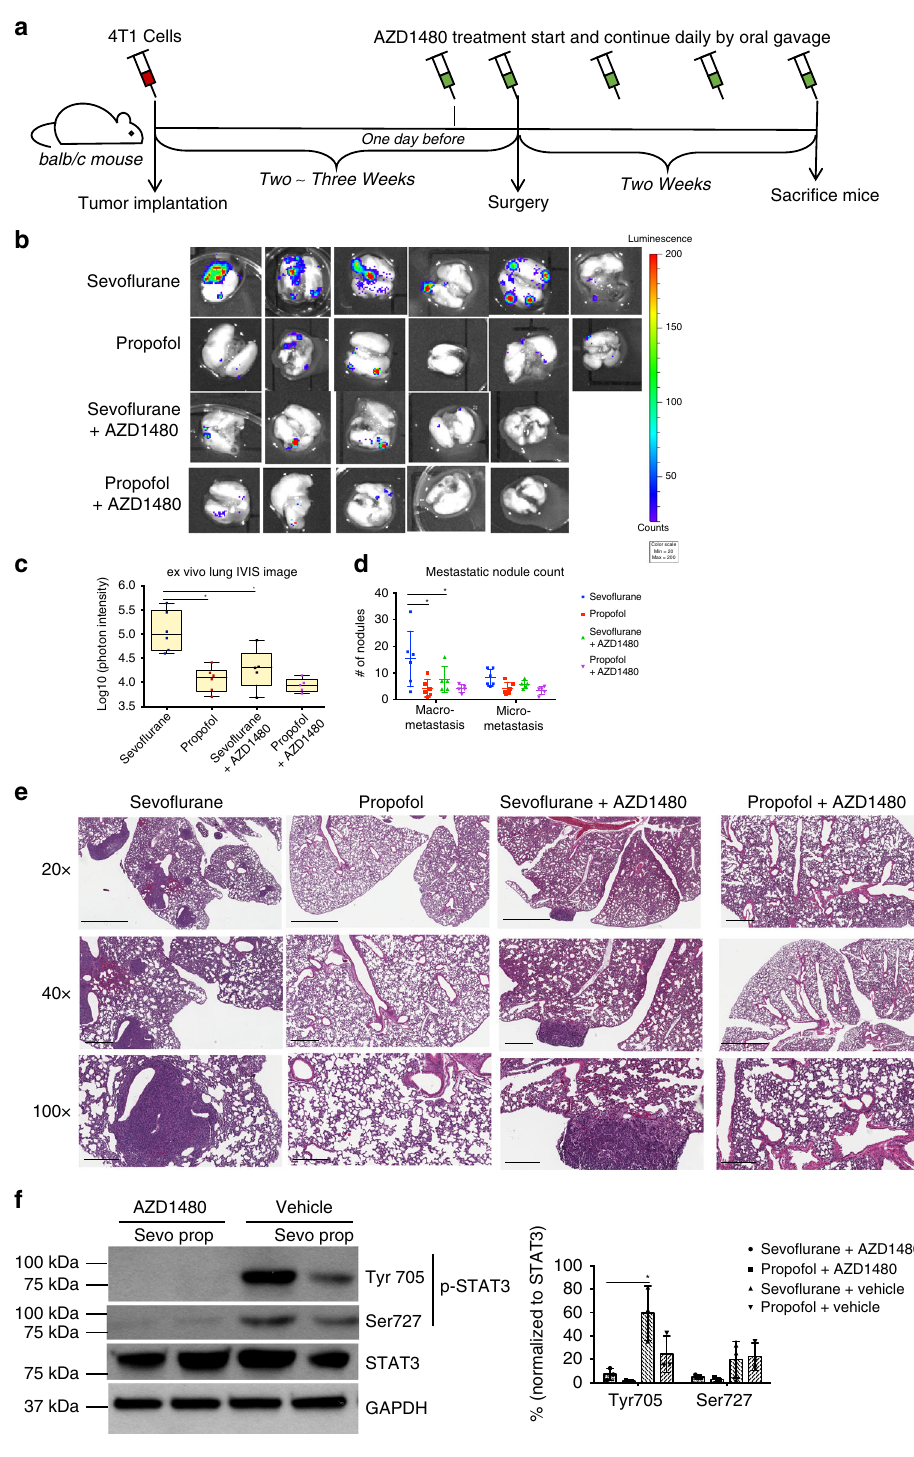
cells in the lung of mice received sevo fl urane one day after surgery (Fig. 4a, p = 0.032, two-way ANOVA + Dunnett ’ s post hoc tests). We also examined CD31 + cells (red) for potential change of vasculature but found no difference between sevo fl urane and propofol with or without AZD1480. The sevo fl urane-induced enrichment of CD11b + cells in the pre-metastatic lung is dependent on IL-6/JAK-STAT3 signaling axis, since AZD1480 also signi fi cantly inhibited the sevo fl urane- induced increase of IL-6 (Fig. 4b; serum, sevo fl urane vehicle